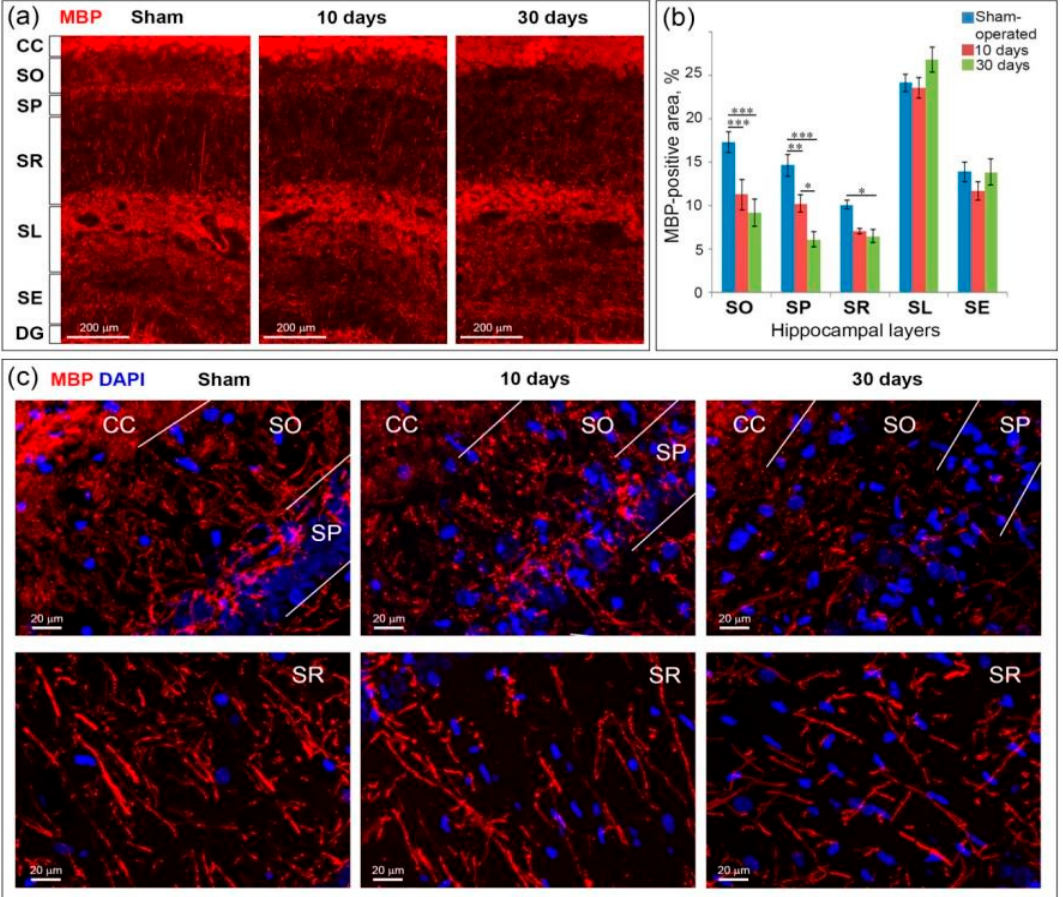
Figure 4. Myelin loss in the hippocampus at Days 10 and 30 after GCI. ( a ) General views of MBP-stained hippocampus at the CA1 field level at Days 10 and 30 after GCI and in sham-operated controls. CC—corpus callosum, SO, SP, SR, SL, SE—hippocampal layers, DG—dentate gyrus, 20 × objective; ( b ) comparison of myelin content between the groups according to the percentage of MBP staining area. Significant di ff erences between the groups, according to ANOVA after LSD correction for multiple comparisons: ***— p < 0.001; **— p < 0.01; *— p < 0.05; ( c ) MIP images of magnified fragments of the hippocampal layers, in which significant changes in the number of MBP after GCI were revealed. 40 × oil immersion